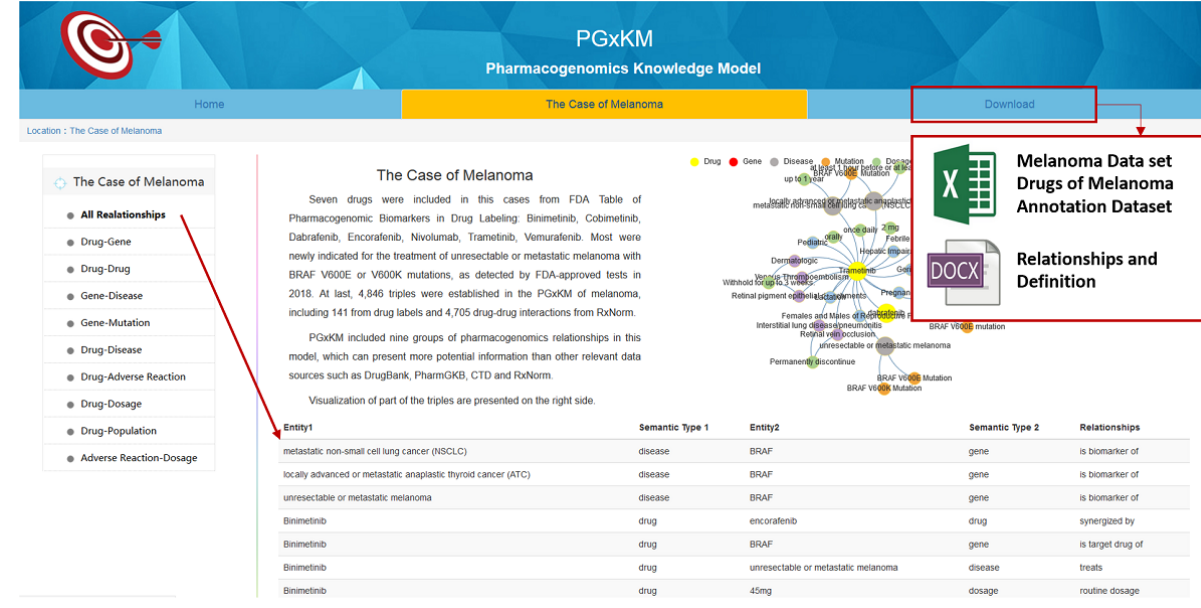
Figure 7. User interface of pharmacogenomics knowledge model data